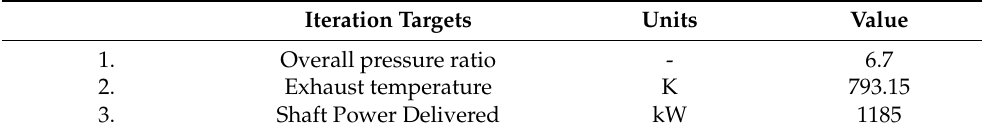
Table 2. Saturn 20 Design-Point Iteration Targets.